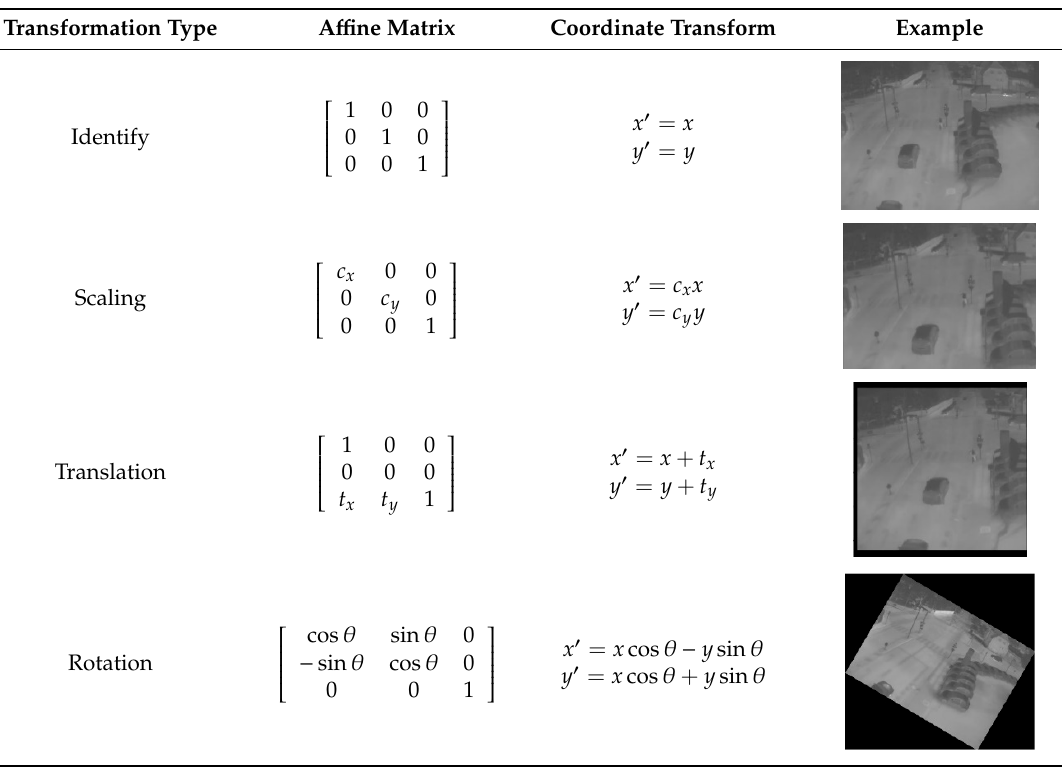
Table A1. Affine matrices used for data enhancement.